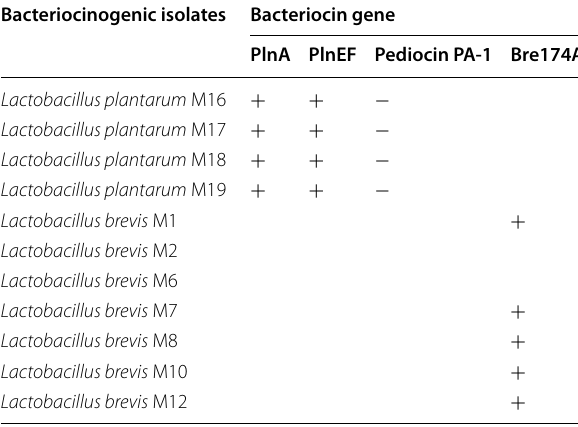
a The number of crosses in the test is related to the diameter of the inhibition halo; in parenthesis, weak inhibition